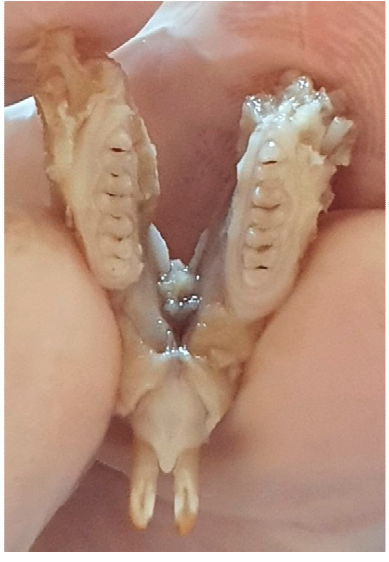
Figure 1. Rat jaw.